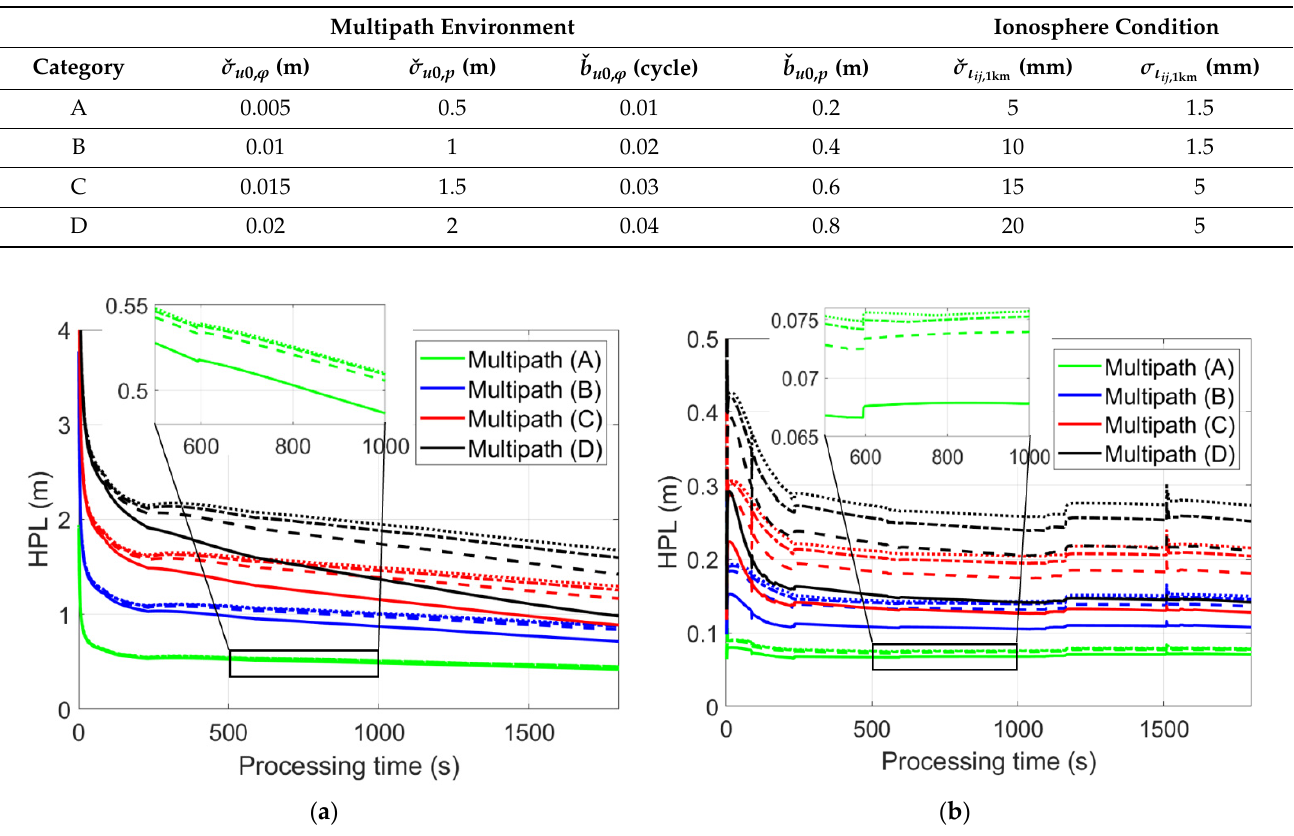
Figure 9. HPLs under different multipath environments and ionosphere conditions ( a ) without and ( b ) with the PAR enabled. The solid, dashed, dashed-dotted and dotted lines represent the ionosphere conditions A, B, C and D, respectively.